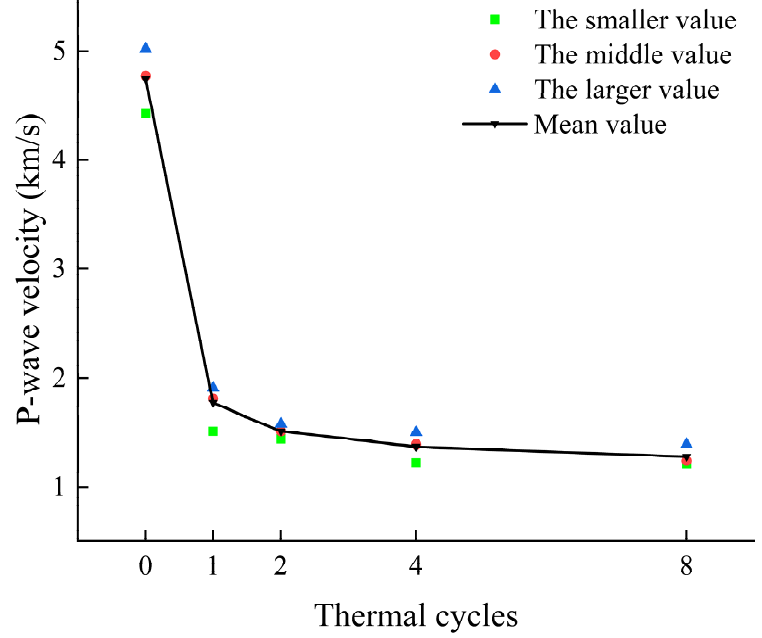
Figure 4. Variation in V p of marble with the number of thermal cycles.